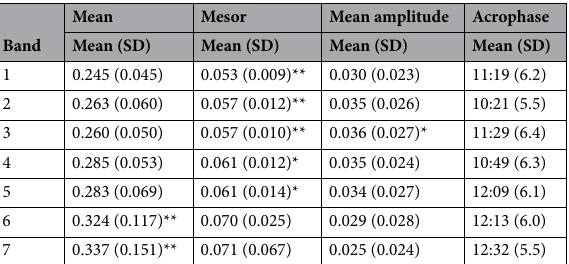
Table 2. Parameters of circadian cosinor regression for coherence. Results of sex adjusted model. In the sex and timing of meals adjusted model, mesor bands 4 and 5, and amplitude band 3 were no longer significant. ** p < .01; * p <